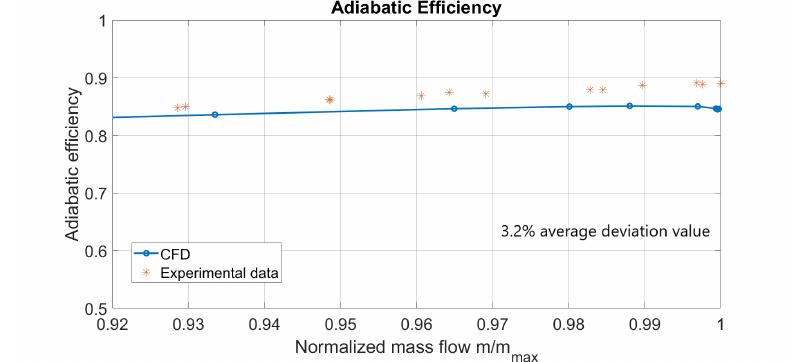
Figure 9. Adiabatic Efficiency comparison between numerical and experimental data. The simulations predicted a near-stall normalized mass flow rate of 0.926 ( m stall / m choke